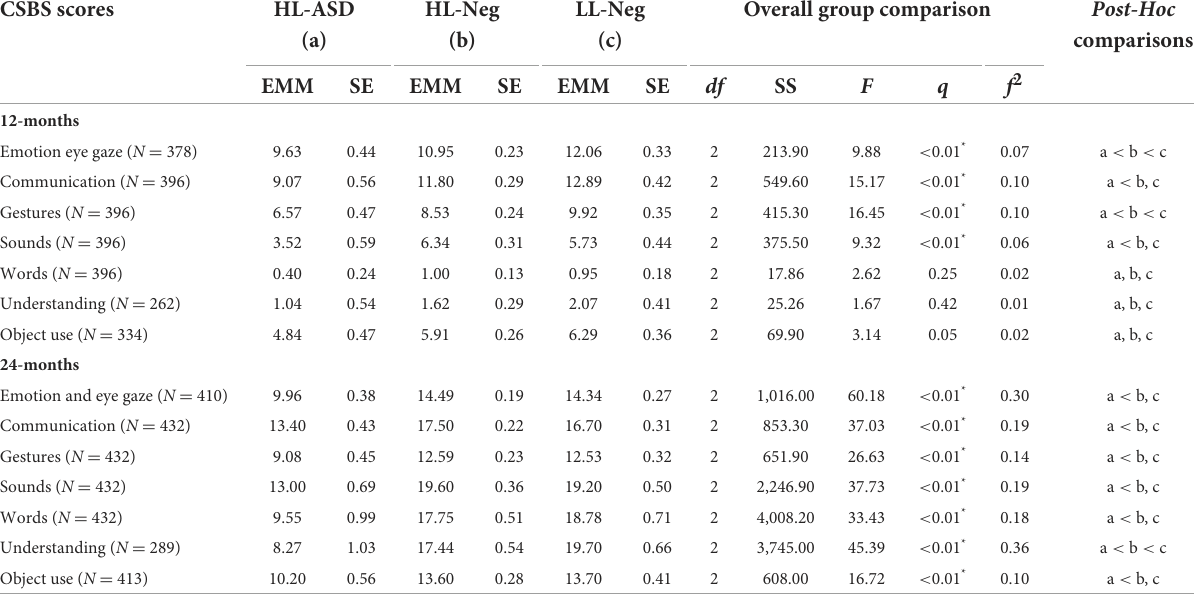
TABLE 4 Post-hoc cross-sectional analysis exploring the main effect for group. CSBS